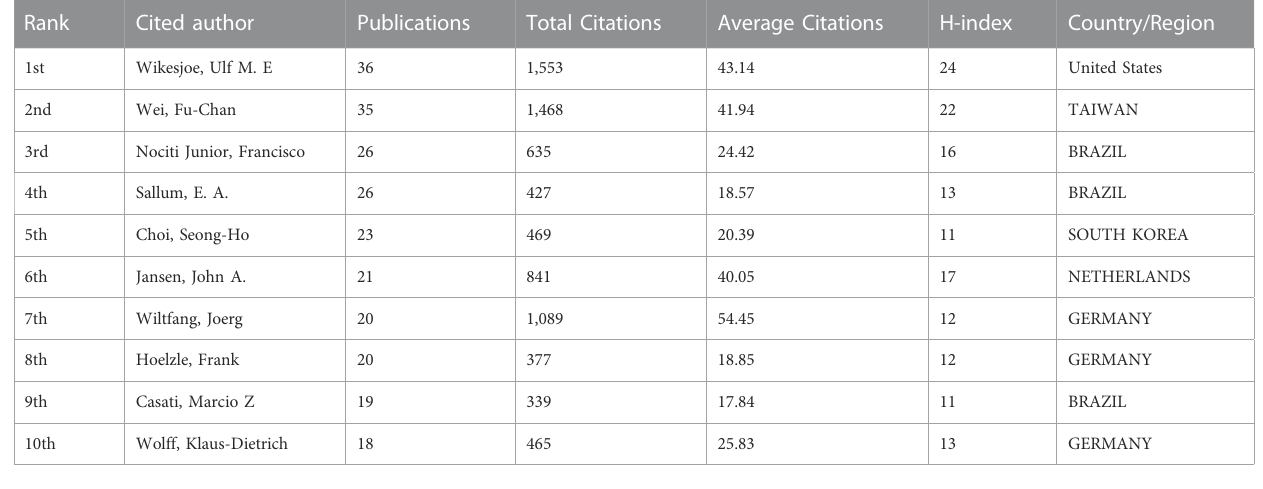
TABLE 2 Top ten authors distributed by publications of mandibular defect